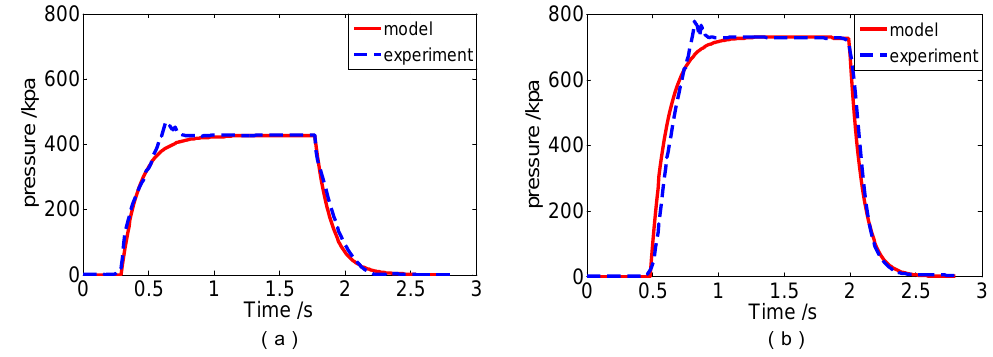
Figure 13. The variation of the brake chamber pressure with different pedal openings. ( a ) ψ = 67%;( b ) ψ = 93%.